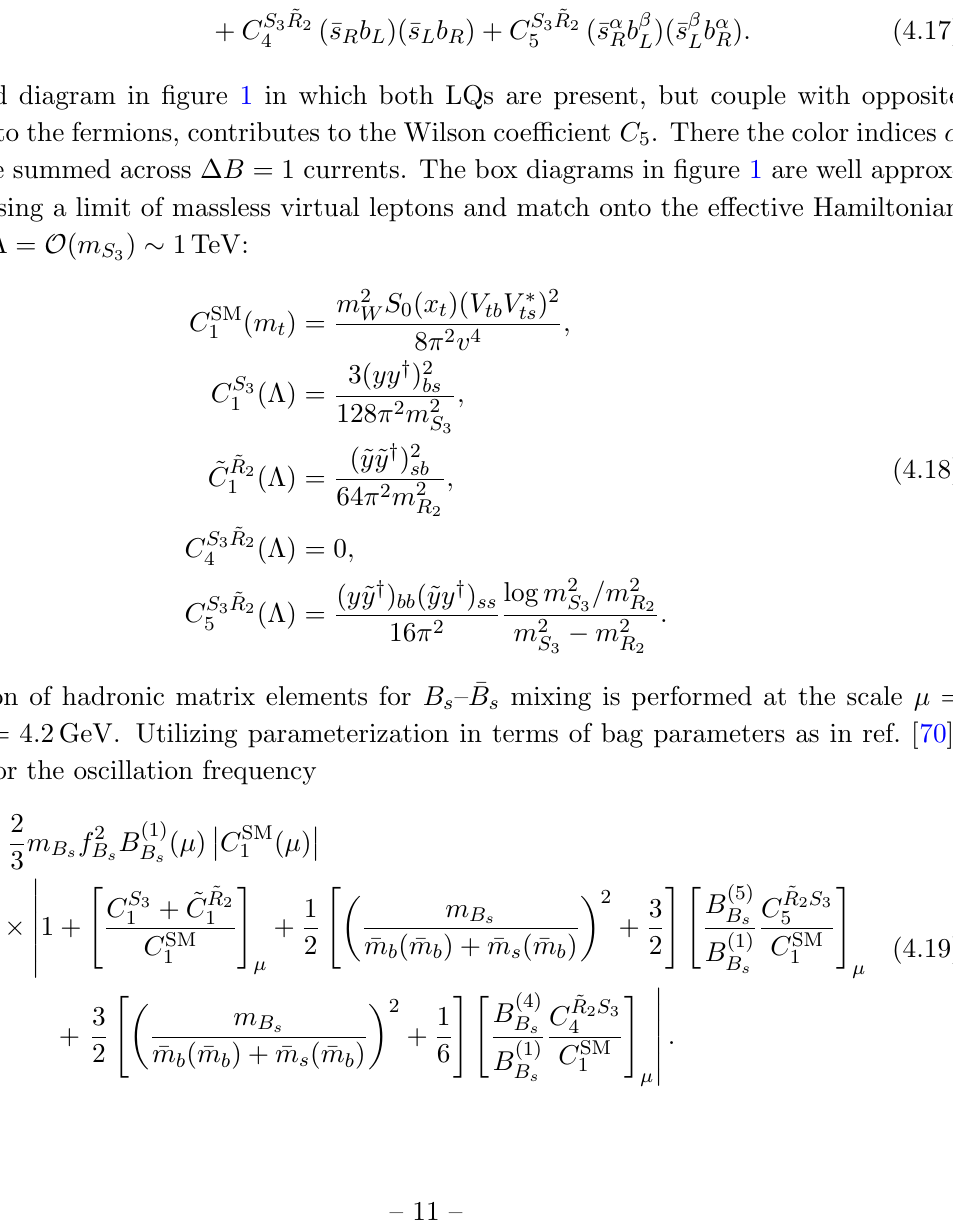
Figure 1 . Three types of box-diagrams with S